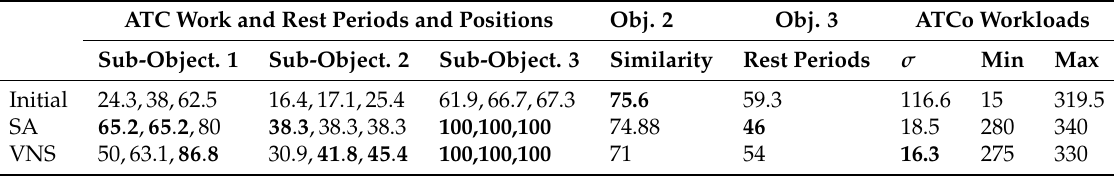
Table 5. Objective functions in the initial solution and solutions reached by SA and VNS for Instance 3. ATC Work and Rest Periods and Positions Obj. 2 Obj. 3 ATCo Workloads Sub-Object. 1